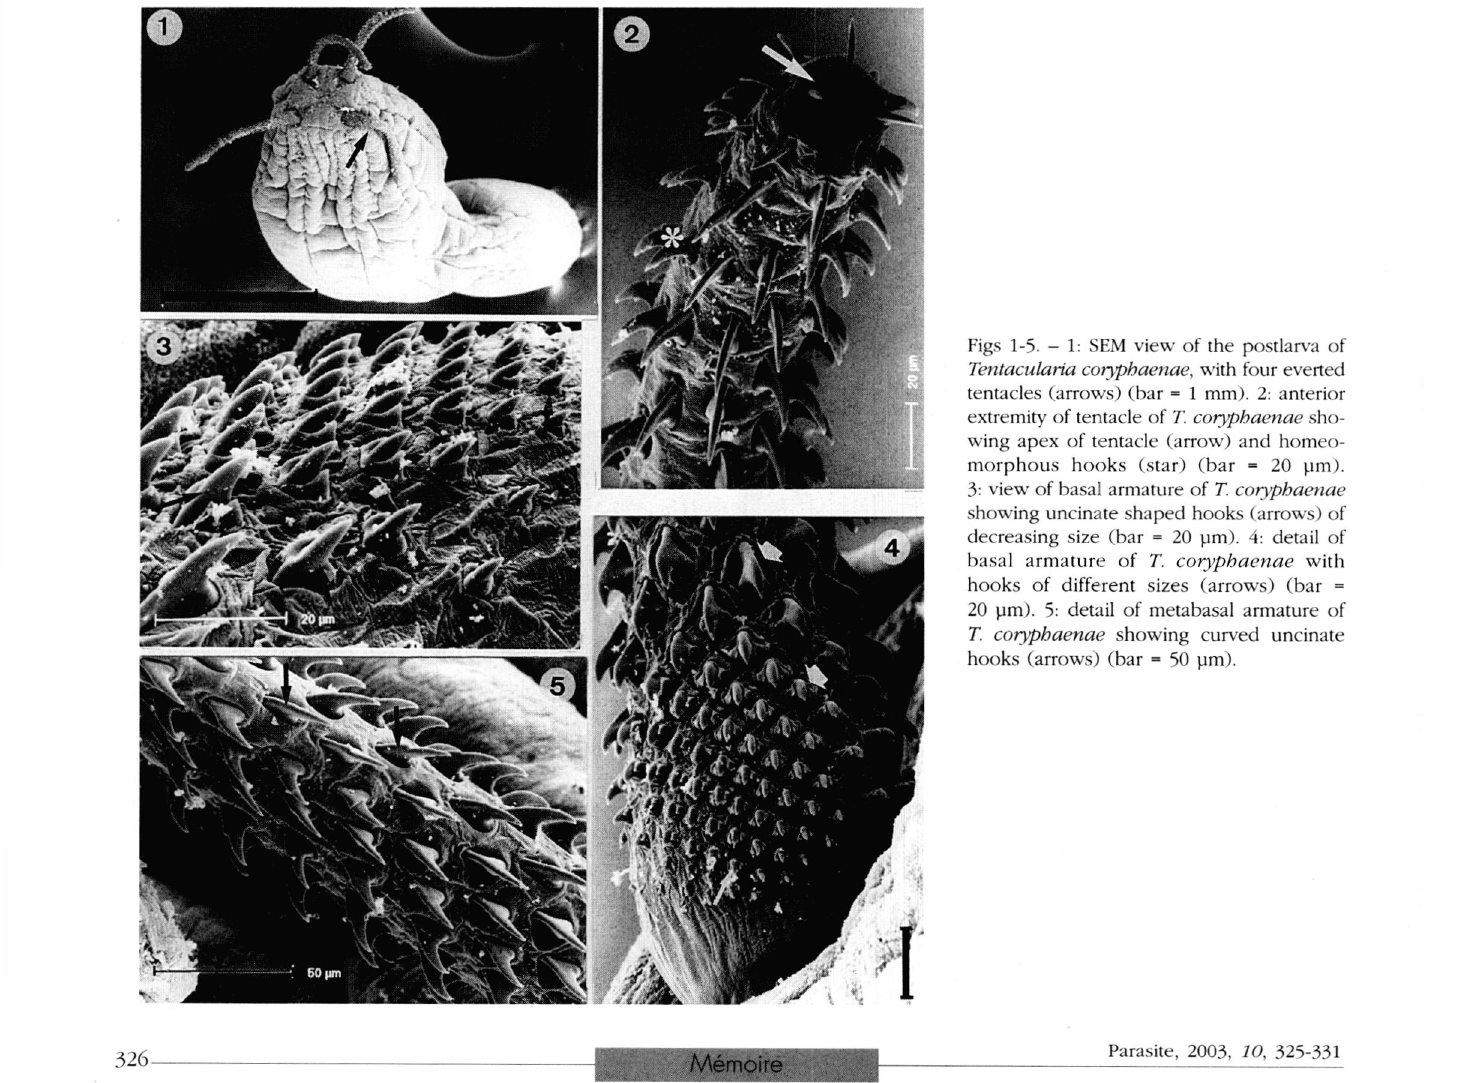
Figs 1-5. - 1: SEM view of the postlarva of Tentacularia coryphaenae, with four everted tentacles (arrows) (bar = 1 mm). 2: anterior extremity of tentacle of T. coryphaenae sho wing apex of tentacle (arrow) and homeo- morphous hooks (star) (bar - 20 µm). 3: view of basal armature of T. coryphaenae showing uncinate shaped hooks (arrows) of decreasing size (bar = 20 µm). 4: detail of basal armature of T. coryphaenae with hooks of different sizes (arrows) (bar = 20 µm). 5: detail of metabasal armature of T. coryphaenae showing curved uncinate hooks (arrows) (bar = 50